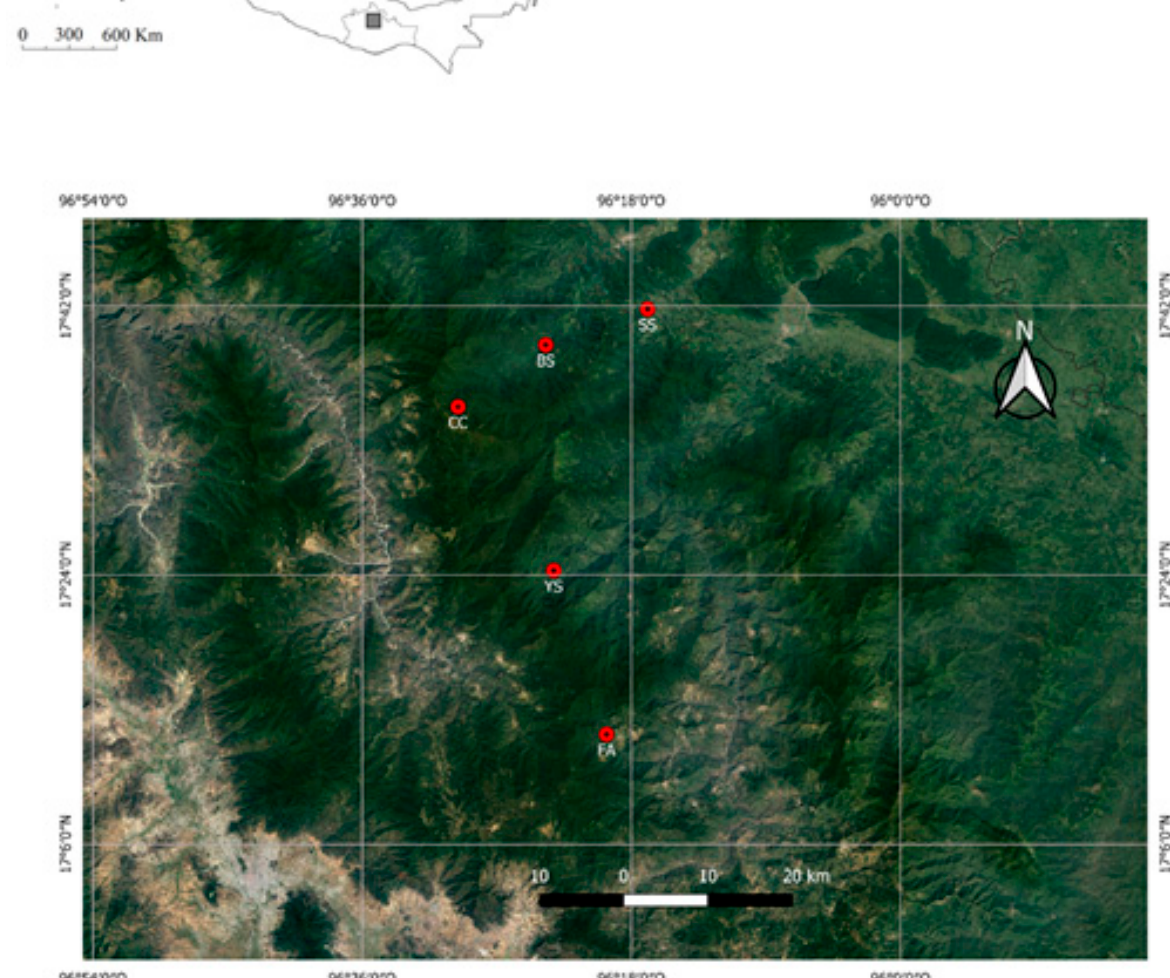
Figure 1. Geographic location of the Sierra de Juárez, Oaxaca, Mexico, and five study sites. SS = Soyolapam stream; BS = Bobo stream; CC = Cascadas de Comaltepec; YS = Yegu-Iag-Lagu stream; FA = Flor de Azahar stream. Modified from Google Earth.